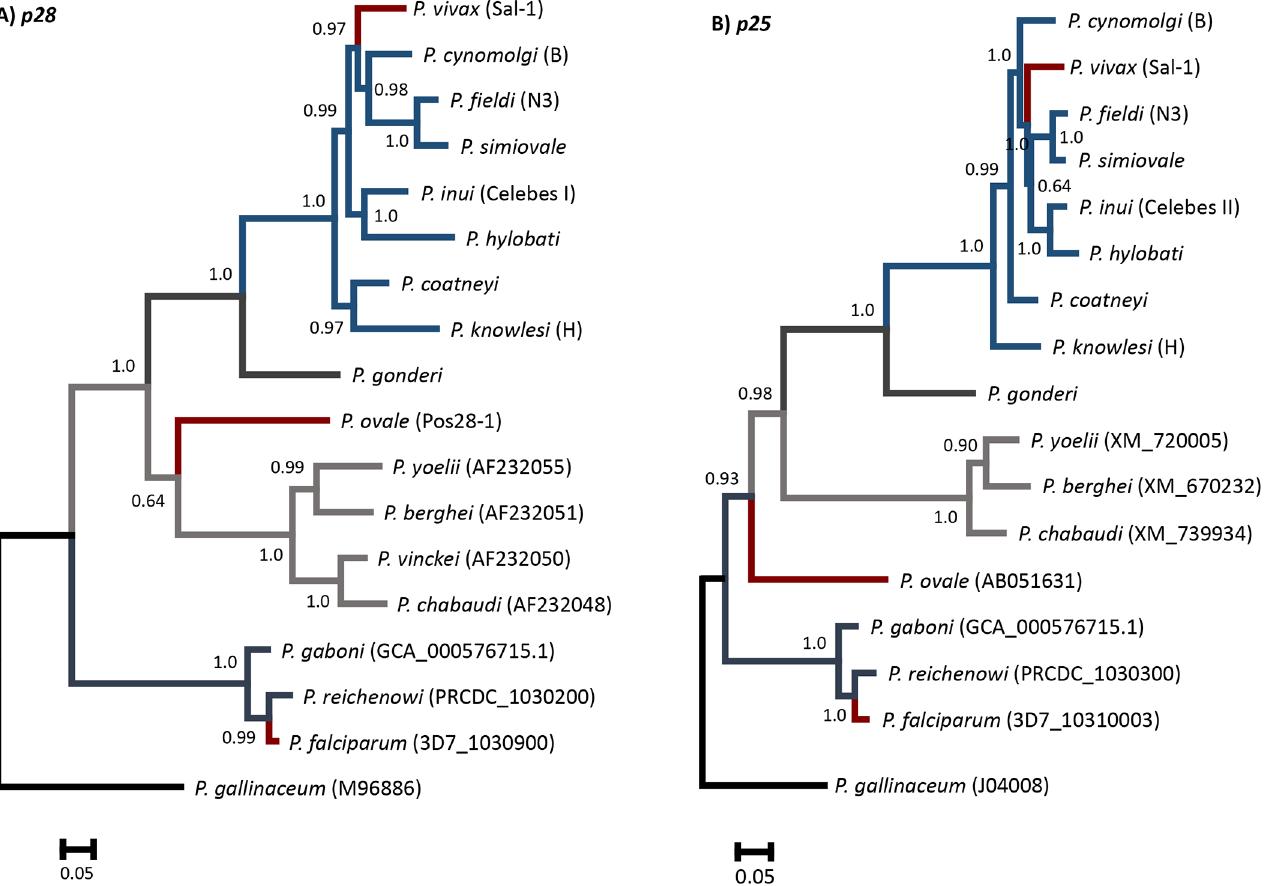
Fig 6. Bayesian phylogenetic hypothesis constructed with nucleotide sequences of the p28 (A) and p25 (B) genes in Plasmodium spp. The values above branches are posterior probabilities (see Methods section). For both phylogenies ( p28 and p25 ), two independent chains were sampled every 200 generations in runs lasting 6 × 10 6 Markov Chain Monte Carlo